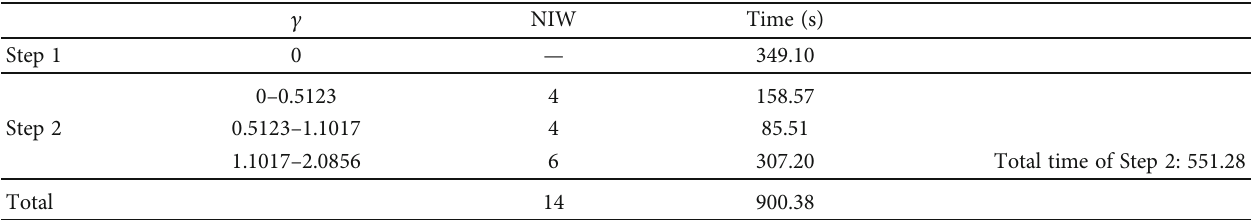
Figure 3: The contours of the ground state density function j ϕ j 2 of (15), where V ω = 0 : 9 , β = 500 , and λ = γβ . Table 2: The execution time (in seconds) for computing the ground state solution of Example 2 by implementing Algorithm 2. NIW: number of iterations in the while loop of Step